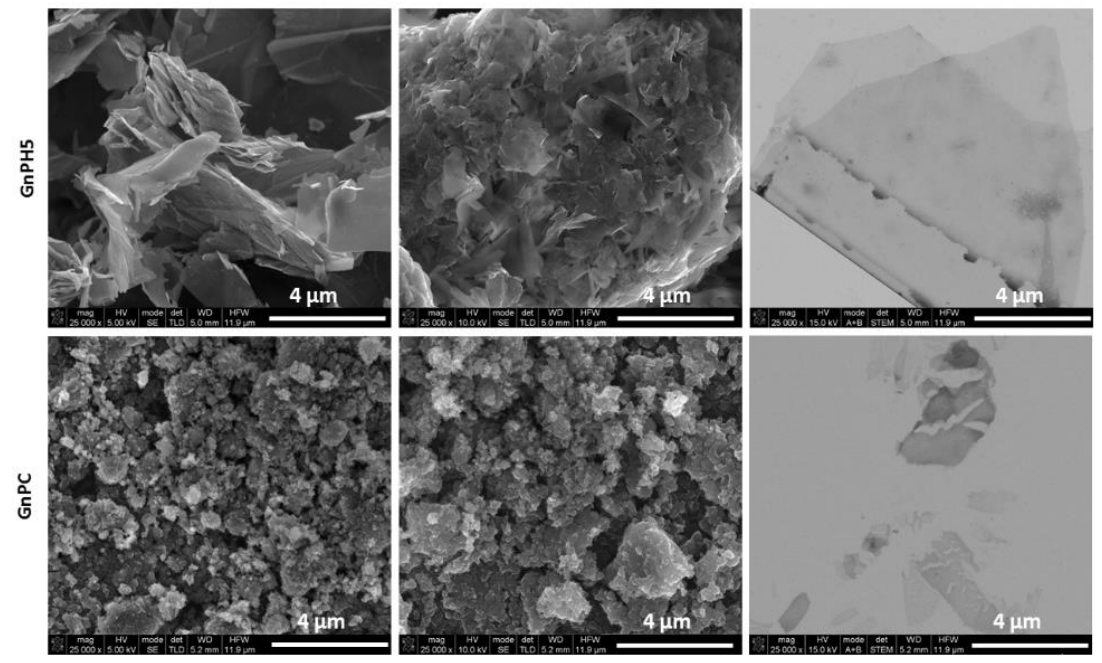
Figure 7. Scanning electron microscopy (SEM) and scanning transmission electron microscopy (STEM) of the graphite starting material and exfoliated